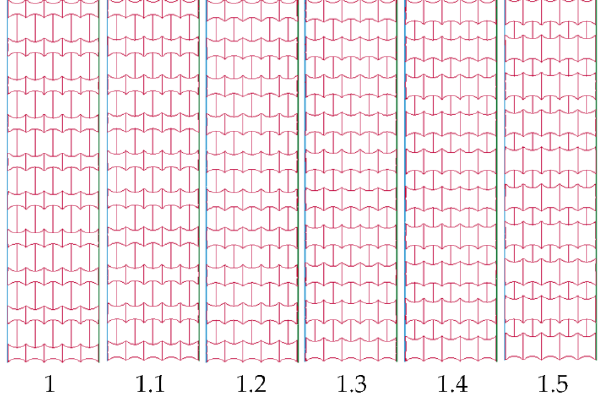
Figure 17. Concave arc honeycomb with different aspect ratio ( l/h ). The deformation contours of the sandwich honeycomb structures with different as- pect ratios are plotted in Figure 18. It can be seen that only one deformation mode (i.e., parallelogram bending) appears.